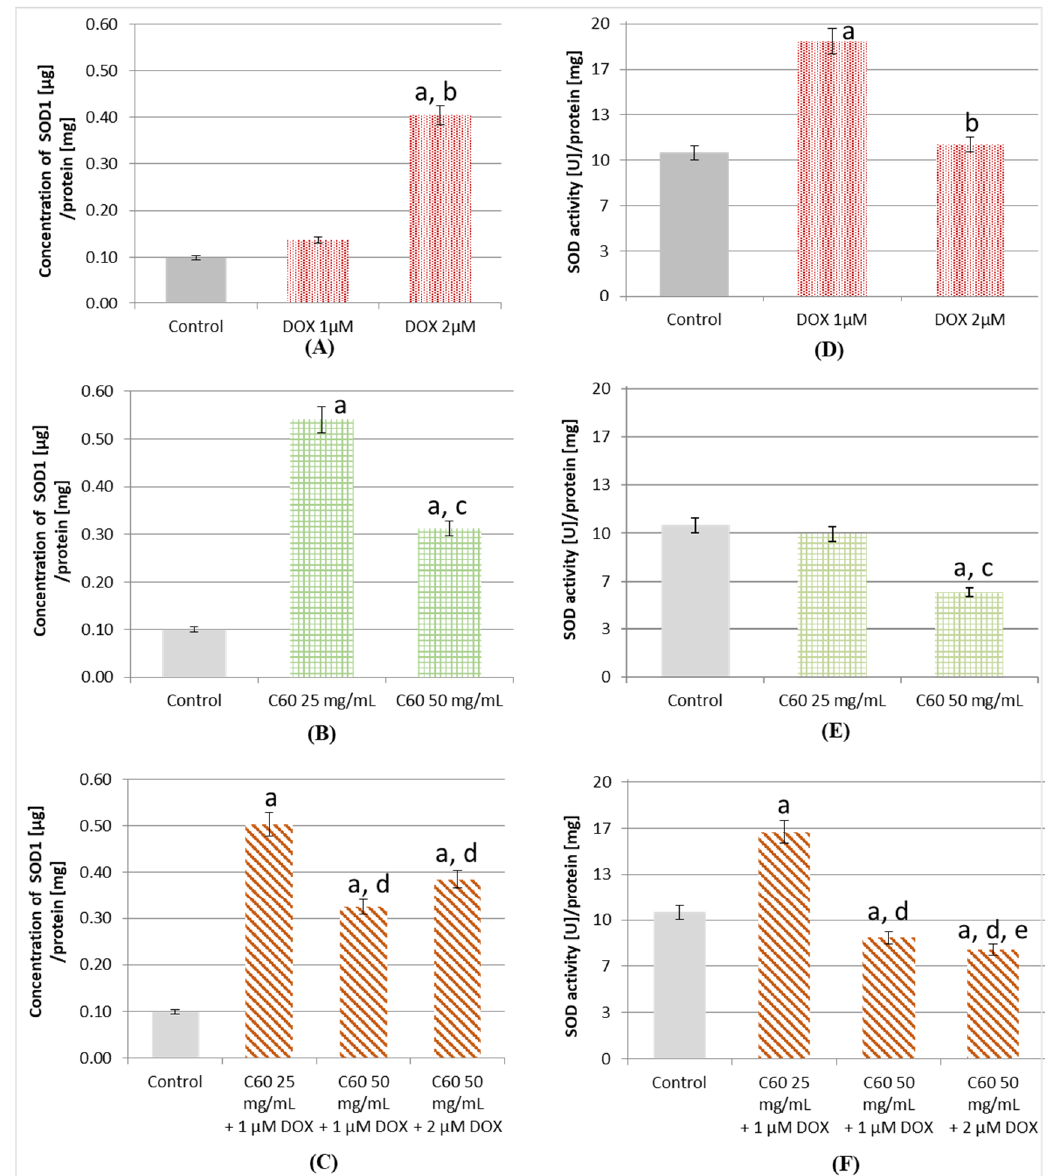
Figure 4. Concentration of superoxide dismutase 1 (SOD1) and activity of SOD in MCF-7 cells treated by DOX, C 60 and C 60 –DOX complexes. Concentration of SOD1 in MCF-7 cells treated by ( A ) DOX, ( B ) C 60 , ( C ) complexes of C 60 –DOX. Activity of SOD in MCF-7 cells treated by ( D ) DOX, ( E ) C 60 , ( F ) complexes of C 60 –DOX. C 60 —fullerene, DOX—doxorubicin. For other experimental conditions, see Material and Methods. a p < 0.05 when compared to control cells; b p < 0.05 when compared to cells treated by 1 µM DOX; c p < 0.05 when compared to cells treated by 25 mg/mL C 60 ; d p < 0.05 when compared to cells treated by C 60 –DOX complexes (25 mg/mL C 60 -1 µM DOX); e p < 0.05 when compared to cells treated by C 60 –DOX complexes (50 mg/mL C 60 -1 µM DOX).